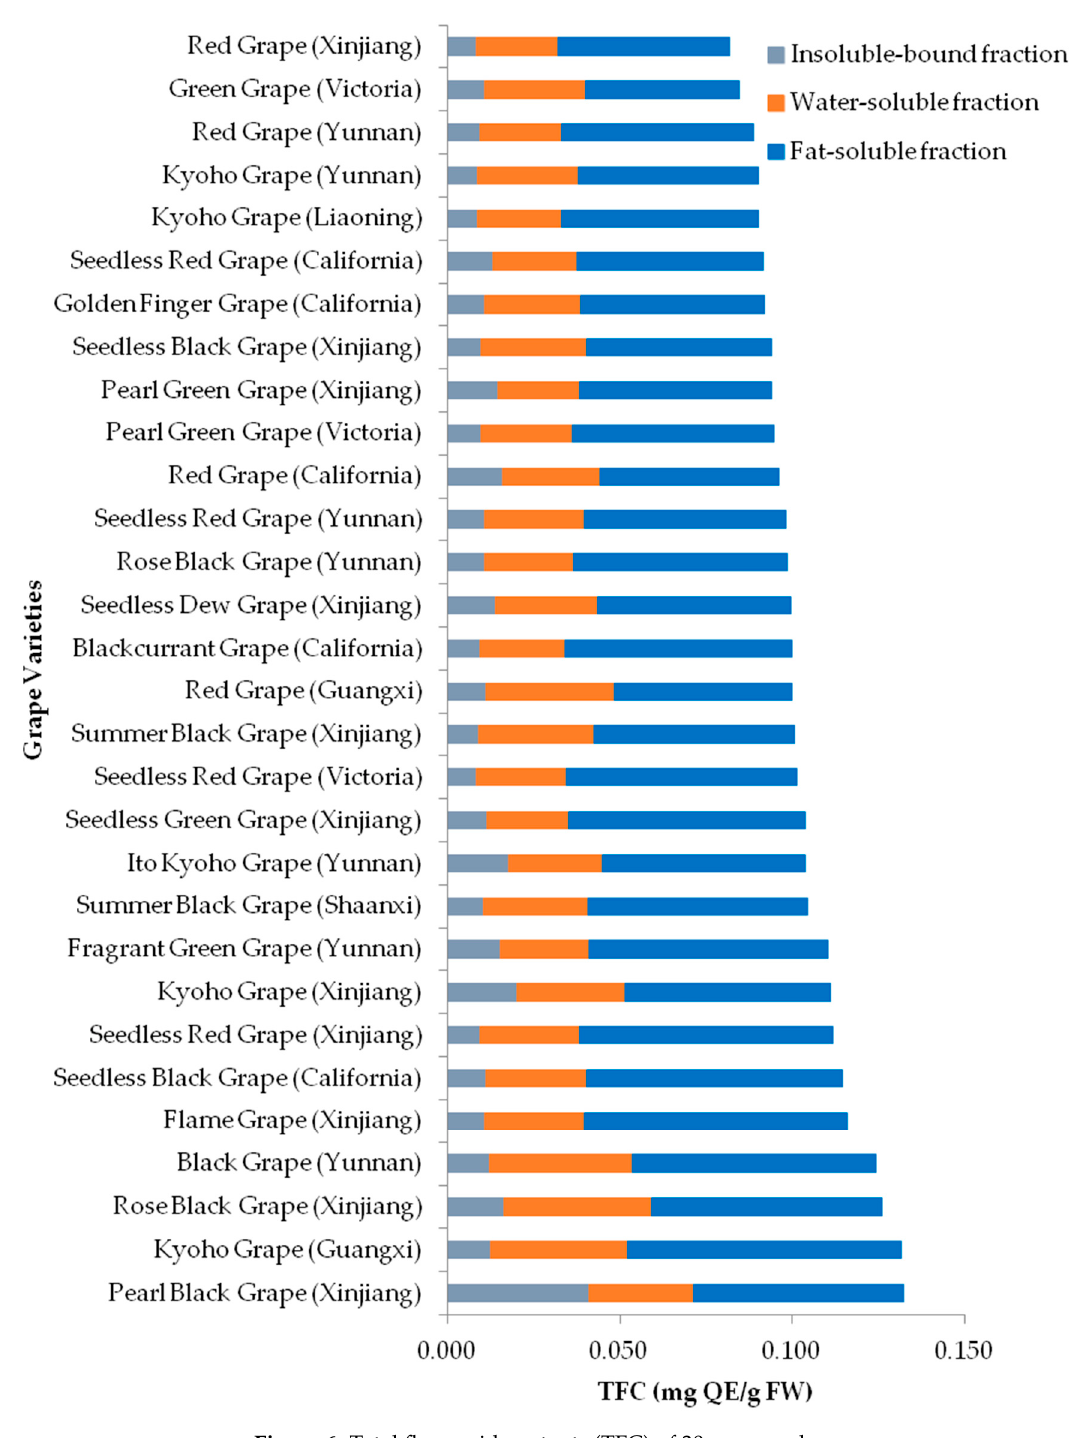
Figure 6. Total flavonoid contents (TFC) of 30 grape pulps.